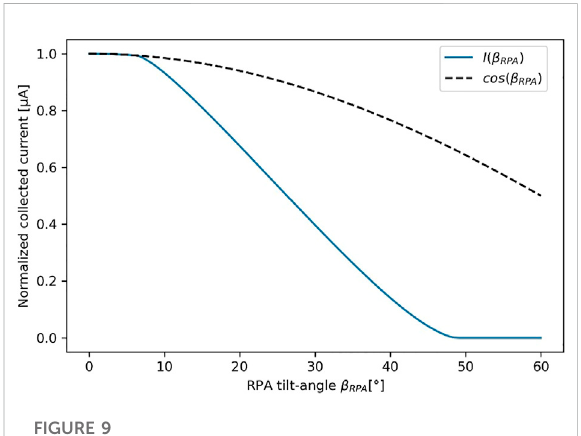
FIGURE 9 Normalized collected current as a function of the RPA tilt- angle β RPA for ϕ A (cid:2) 0V . The velocity distribution is sampled from a shifted Maxwellian with T i (cid:2) 0 . 2eV , E shift (cid:2) 250eV , Xe +